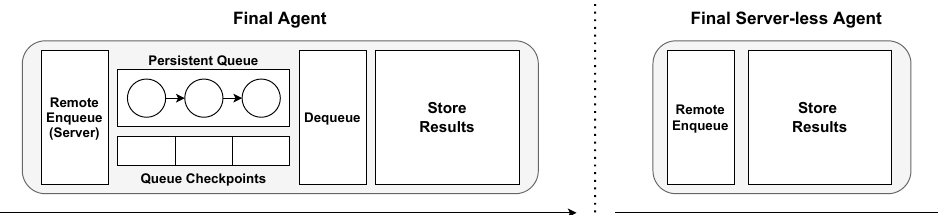
Figure 9. Final worker agents. This type of agent is used to finalize one or several pipelines. The agent retrieves the end results from either a local or a remote queue, then handles the result in a customized manner.